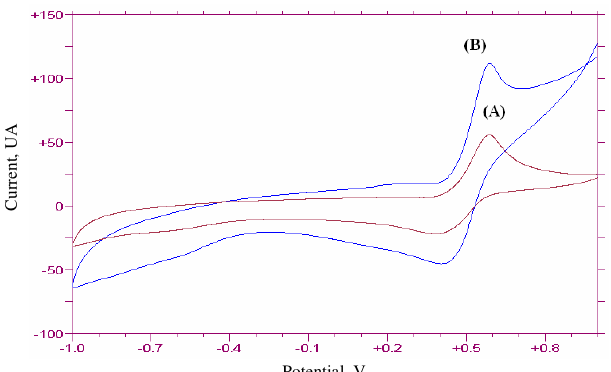
Figure 1. Cyclic voltammograms for oxidation of 0.1 mM paracetamol obtained in 0.1 M KH P0 (pH 6.0 ), with potential scanning in the positive direction from -1000 to +1000 mV 2 4 vs. Ag/AgCl at a scan rate of 100 mV/s at 25 °C at (a) bare GC electrode and (b) modified MgB /GC 2